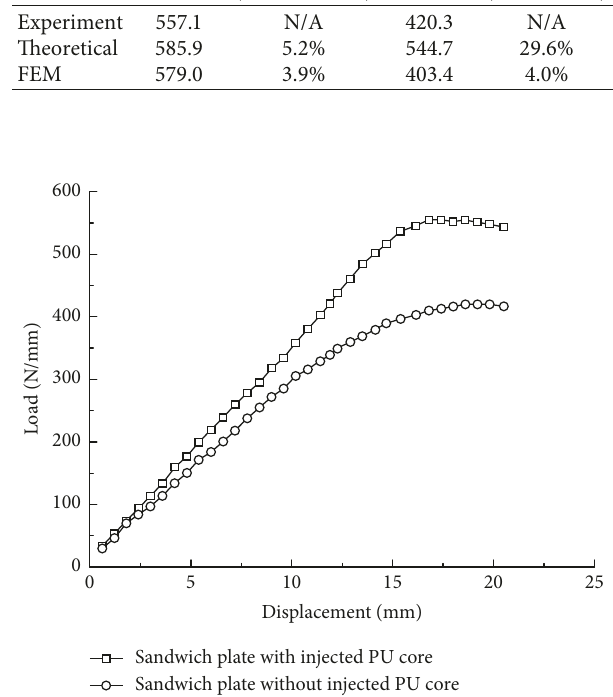
Figure 19: Load-displacement curve obtained in the